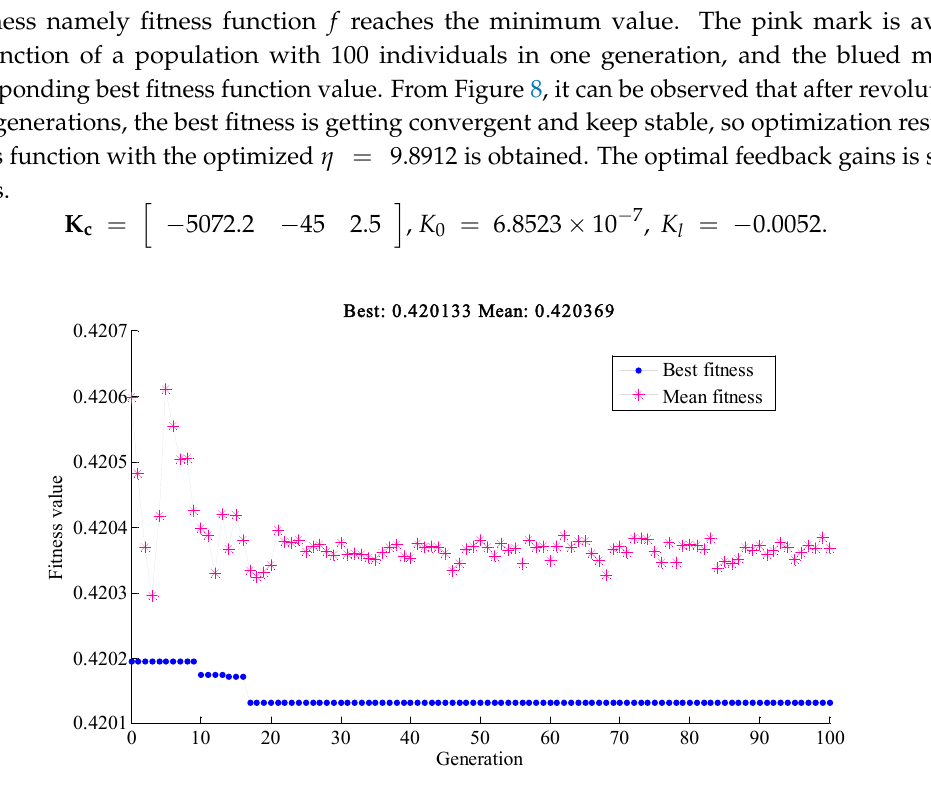
Figure 8. Optimized fitness result.